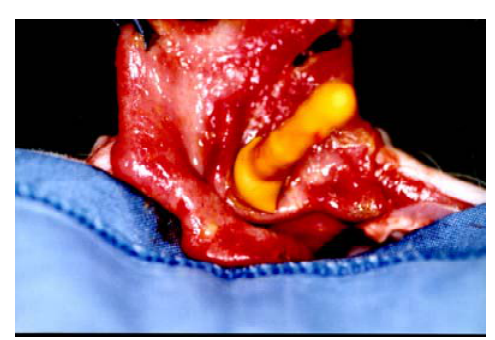
FIGURE 17 - Surgery view of Foley baloom